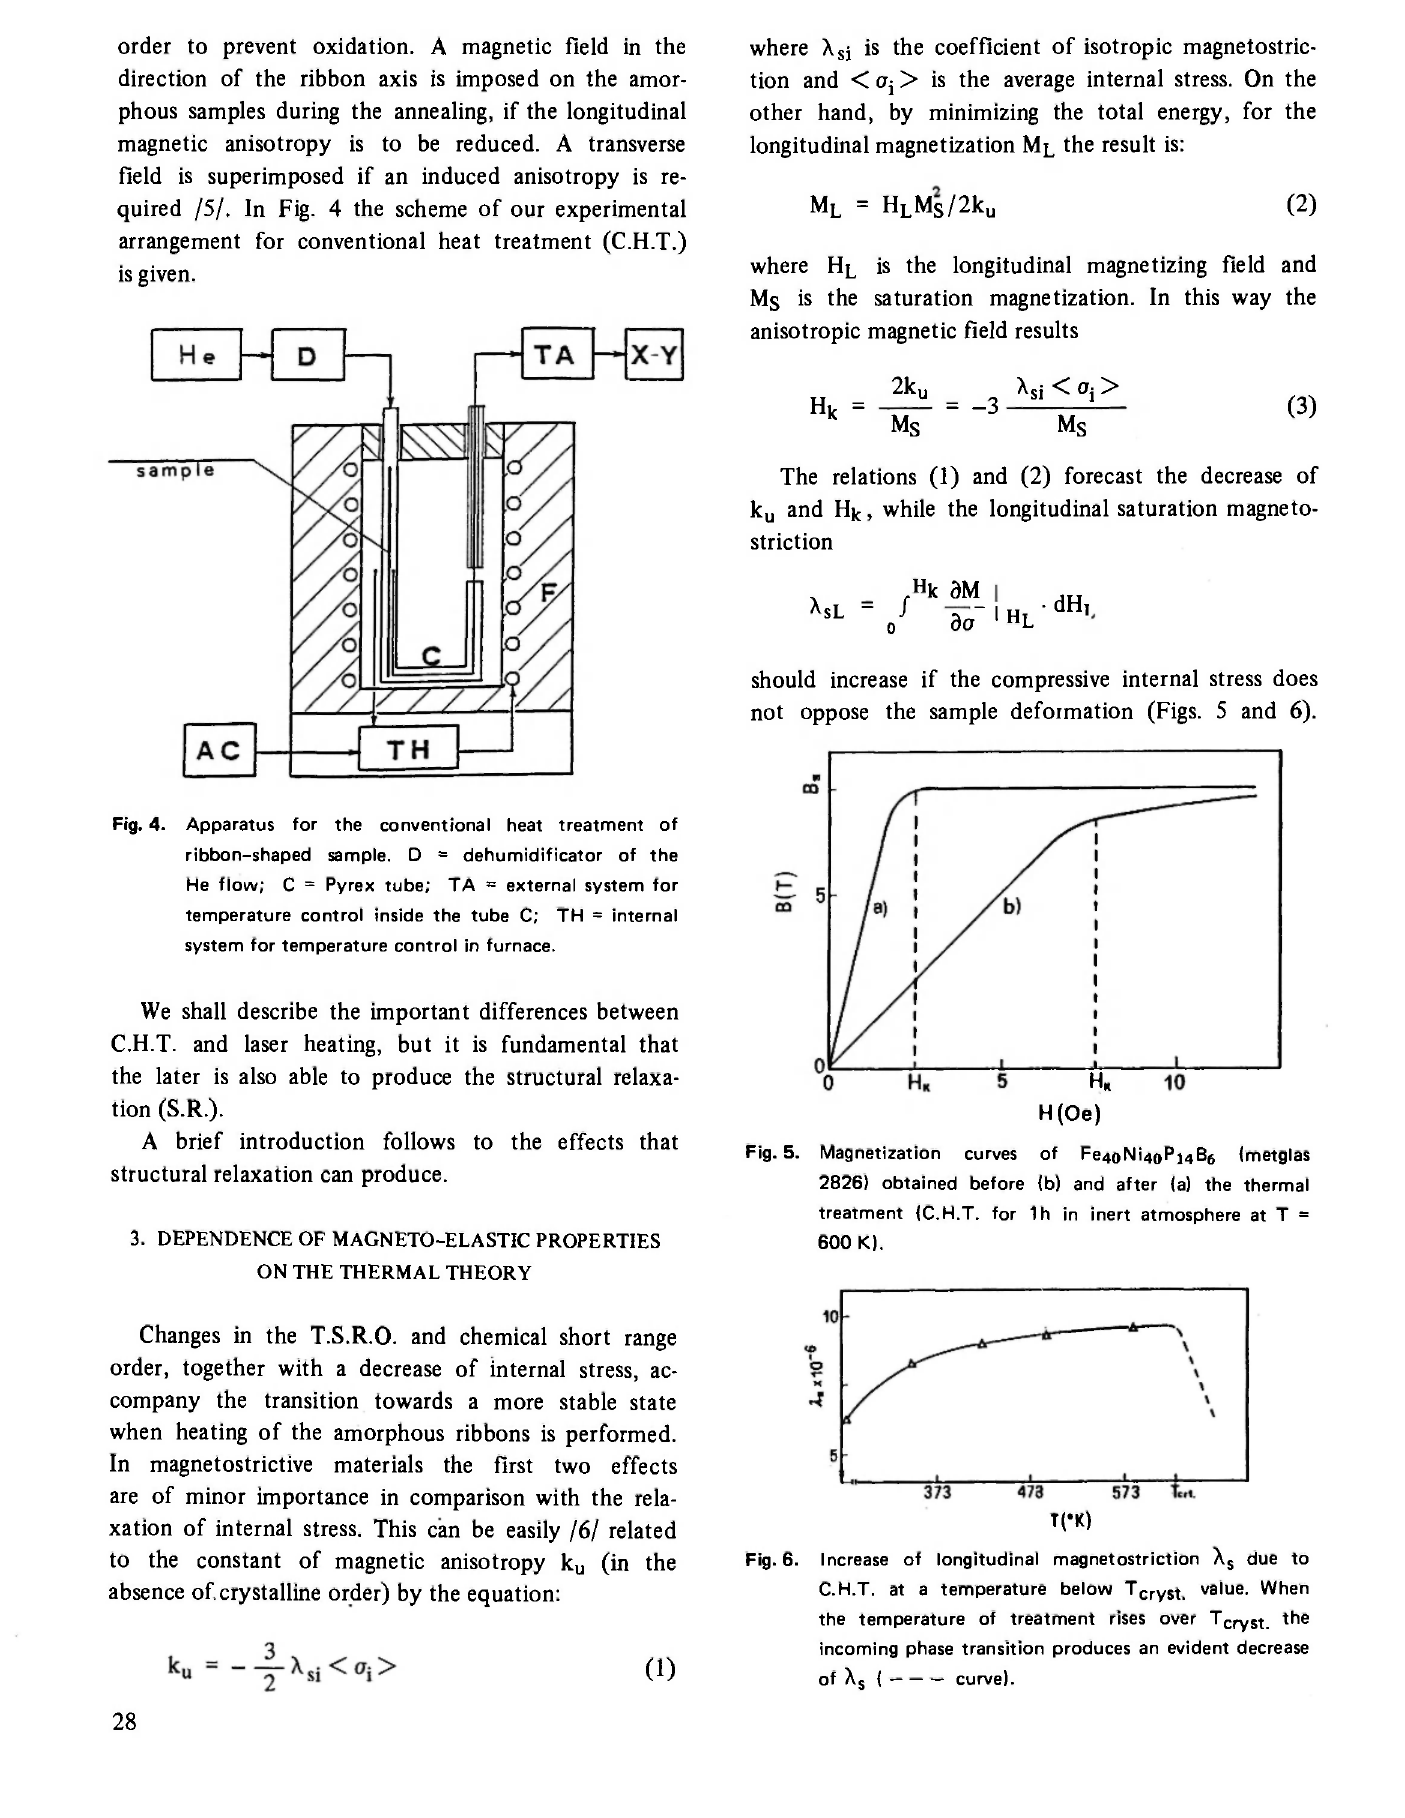
H, Η (Oe) Fig. 5. Magnetization curves of Fe40Ni4 0 Pi4B 6 (metglas 2826) obtained before (b) and after (a) the thermal treatment (C .H.T. for 1h in inert atmosphere at Τ = 600 Κ).